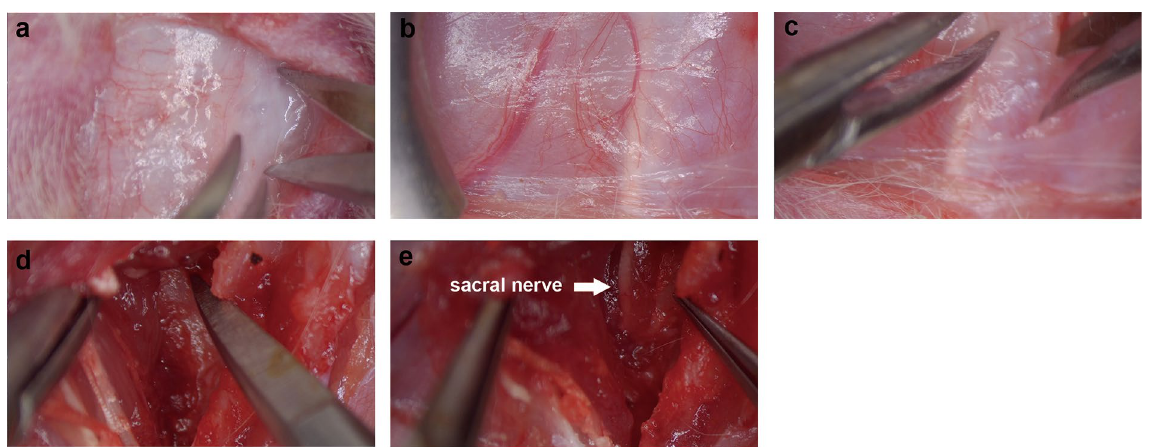
Figure 2. Surgical procedure of spinal sacral nerve injury. ( a - c ) Skin was dissected and spinal process was identified, paravertebral muscle was separated from vertebral. ( d ) Dorsal sacral foramen was identified. ( e ) Spinal sacral nerve 2 was